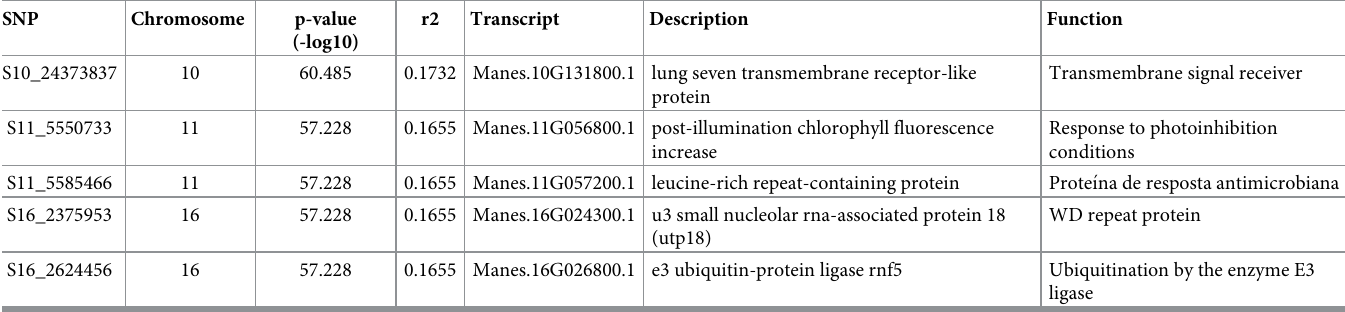
Table 3. Relationship of single nucleotide polymorphisms markers and traits after applying the Bonferroni correction (p < 0.05) for fresh root yield in cassava